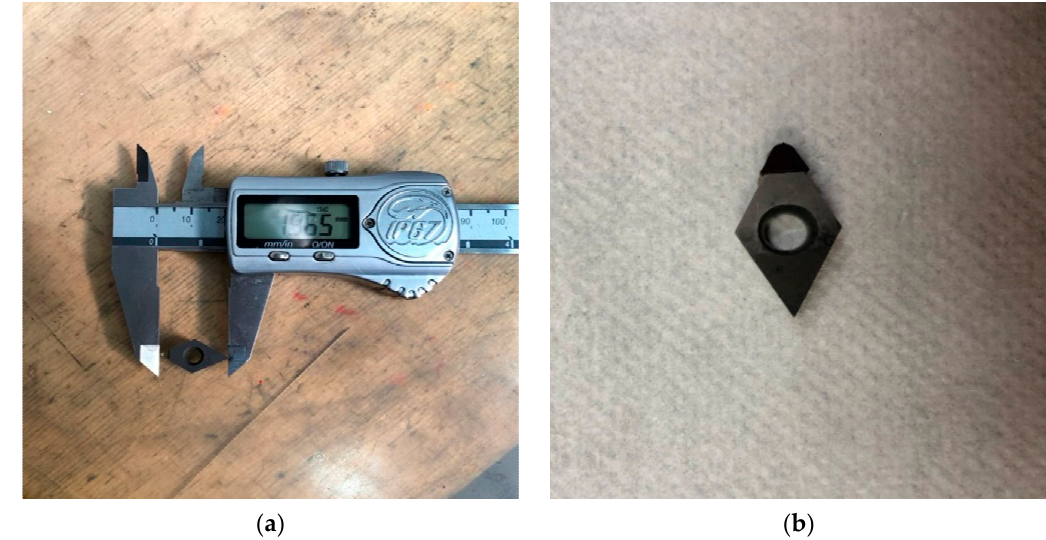
Figure 3. ( a ) Shape of the cutting insert with PCD blade before sharpening; ( b ) Cutting insert after sharpening.